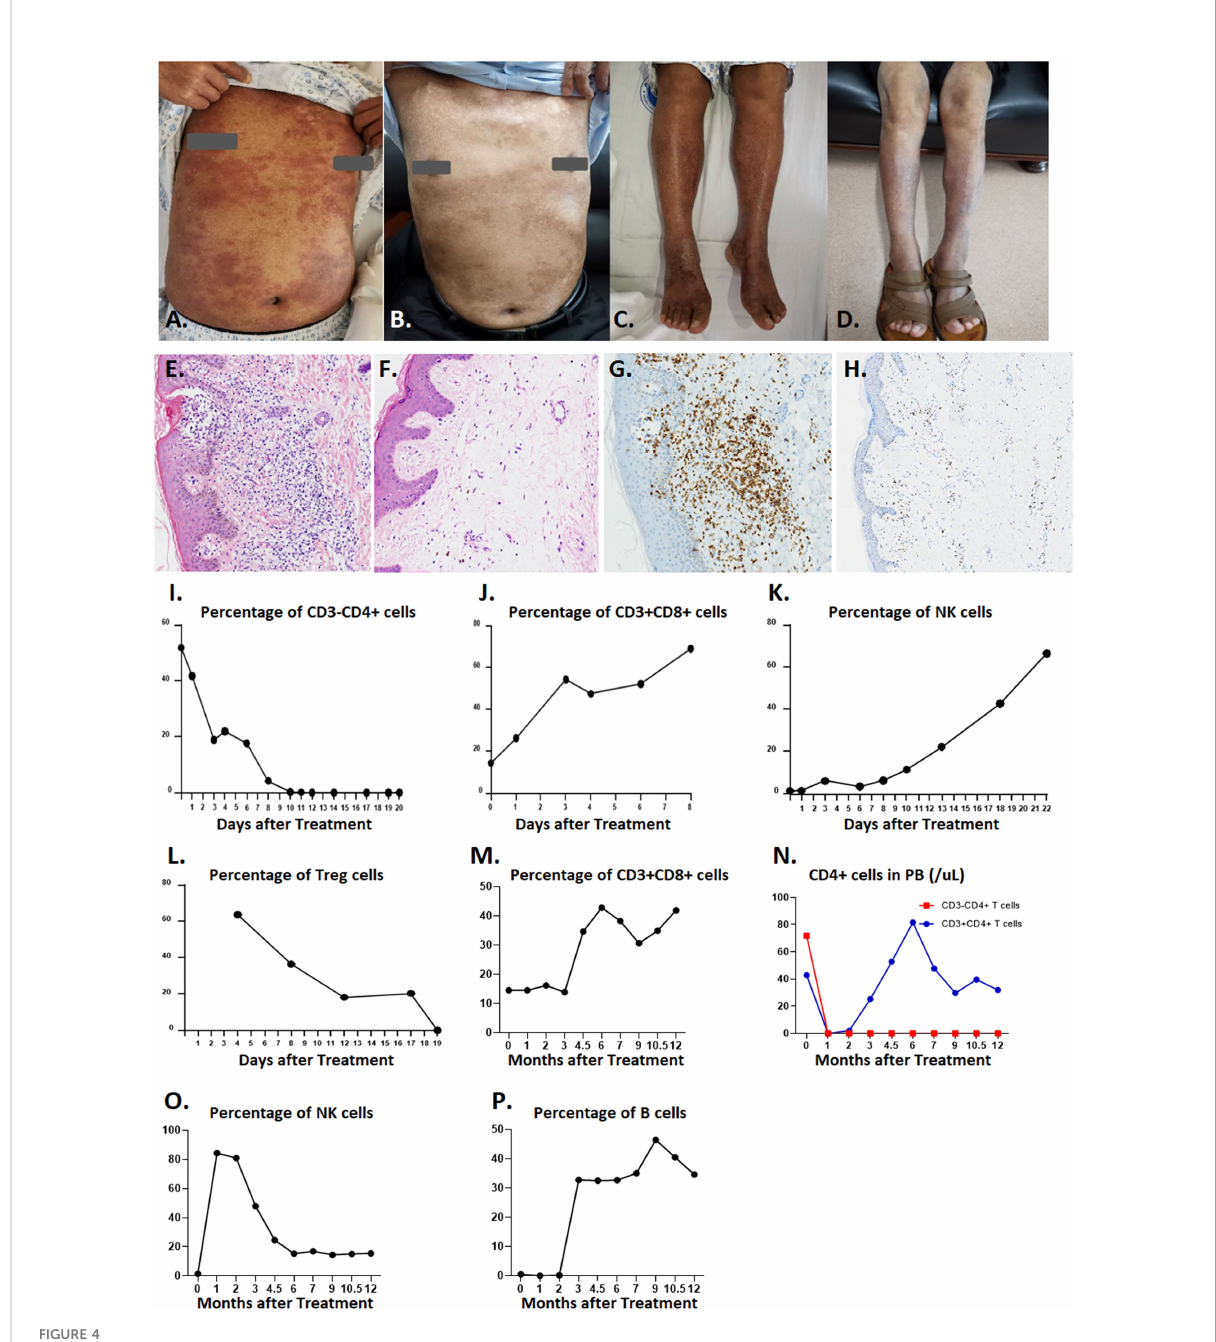
FIGURE 4 Ef fi ciency of CD4-IL15/IL15sushi CAR T cells in Patient 1 with Se ́ zary syndrome. (A) Chest skin appearance with marked erythema and swelling before treatment with CD4-IL15/IL15sushi CAR T cells. (B) Chest skin appearance on Day 28 post-infusion. (C) Leg skin appearance before treatment with CD4-IL15/IL15sushi CAR T cells. (D) Leg skin appearance on Day 28 post- infusion. (E) H&E staining of skin biopsy before treatment with CD4-IL15/IL15sushi CAR T cells, showing extensive lymphocytic in fi ltration. (F) H&E staining of skin biopsy 28 days after treatment, showing signi fi cantly diminished lymphocyte levels. (G) CD4 expression of leukemic Se ́ zary cells in skin biopsy before treatment. (H) Diminished CD4 expression in skin biopsy 28 days after treatment. (I) CD3-CD4+ leukemic Se ́ zary cells dramatically diminished within 20 days after infusion with CD4-IL15/IL15sushi CAR T cells. (J) Expansion of CD3+CD8+ cells within 8 days after infusion with CD4-IL15/IL15sushi CAR T cells. (K) Expansion of NK cells within 22 days after infusion. (L) Decreased Treg cells within 19 days after infusion. (M) Long-term expansion of CD3+CD8+ cells 1 year after infusion. (N) Decreased CD3-CD4+ cell counts in peripheral blood remained undetectable for the next year after treatment (orange curve), whereas CD3+CD4+ cells were depressed during the fi rst month post-treatment followed by recovery in the next few months (blue curve) after treatment, which indicates that immune reconstitution can be observed post-treatment. (O) Transient expansion of NK cells to 84.41% during the fi rst month post-treatment following by a gradual decrease until 6 months and maintenance of that level for 6 more months. (P) Initial suppression of B cells for 2 months followed by